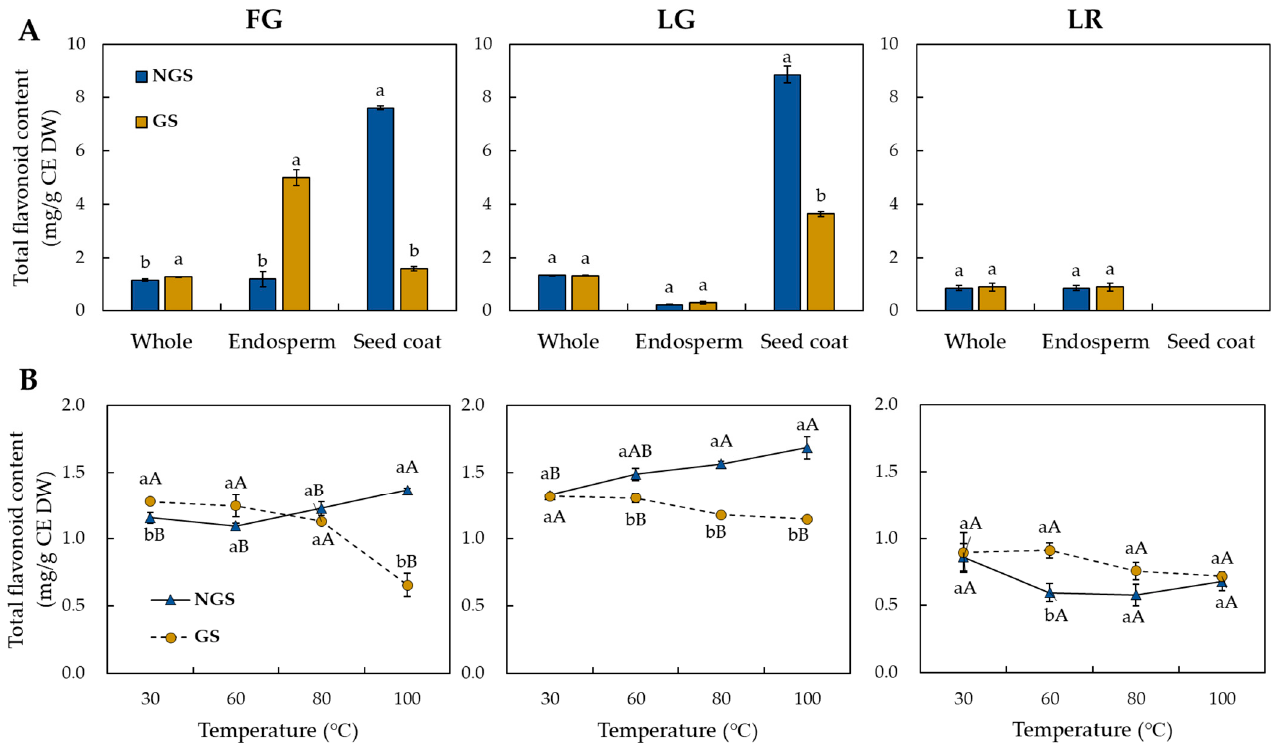
Figure 3. Changes in TFC of ( A ) different cultivars of lentil NGS and GS in whole, seed coat, and endosperm, ( B ) whole NGS and GS during different thermal treatment. Different lowercase letters indicate the significant differences (Tukey’s studentized test at p < 0.05) between NGS and GS, and capital letters indicates the significant differences (Tukey’s studentized test at p < 0.05) between lentil cultivars treated with different temperatures.